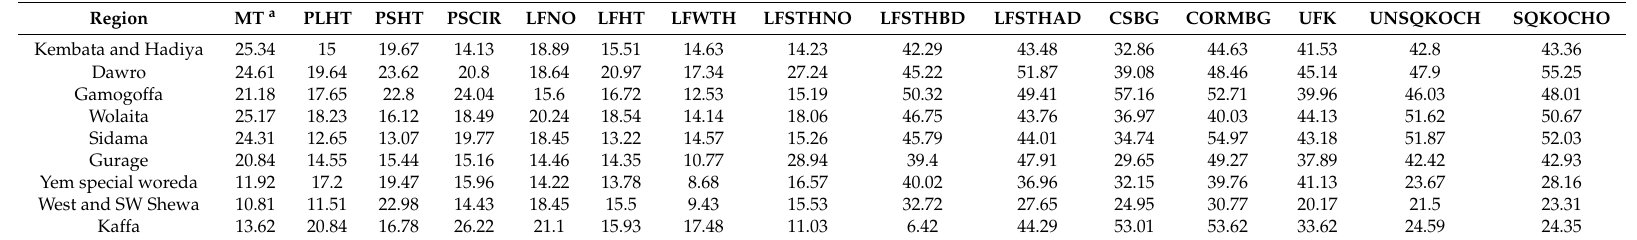
Table 5. Percent of coefficients of variation for 15 quantitative characteristics in enset germplasm by region of